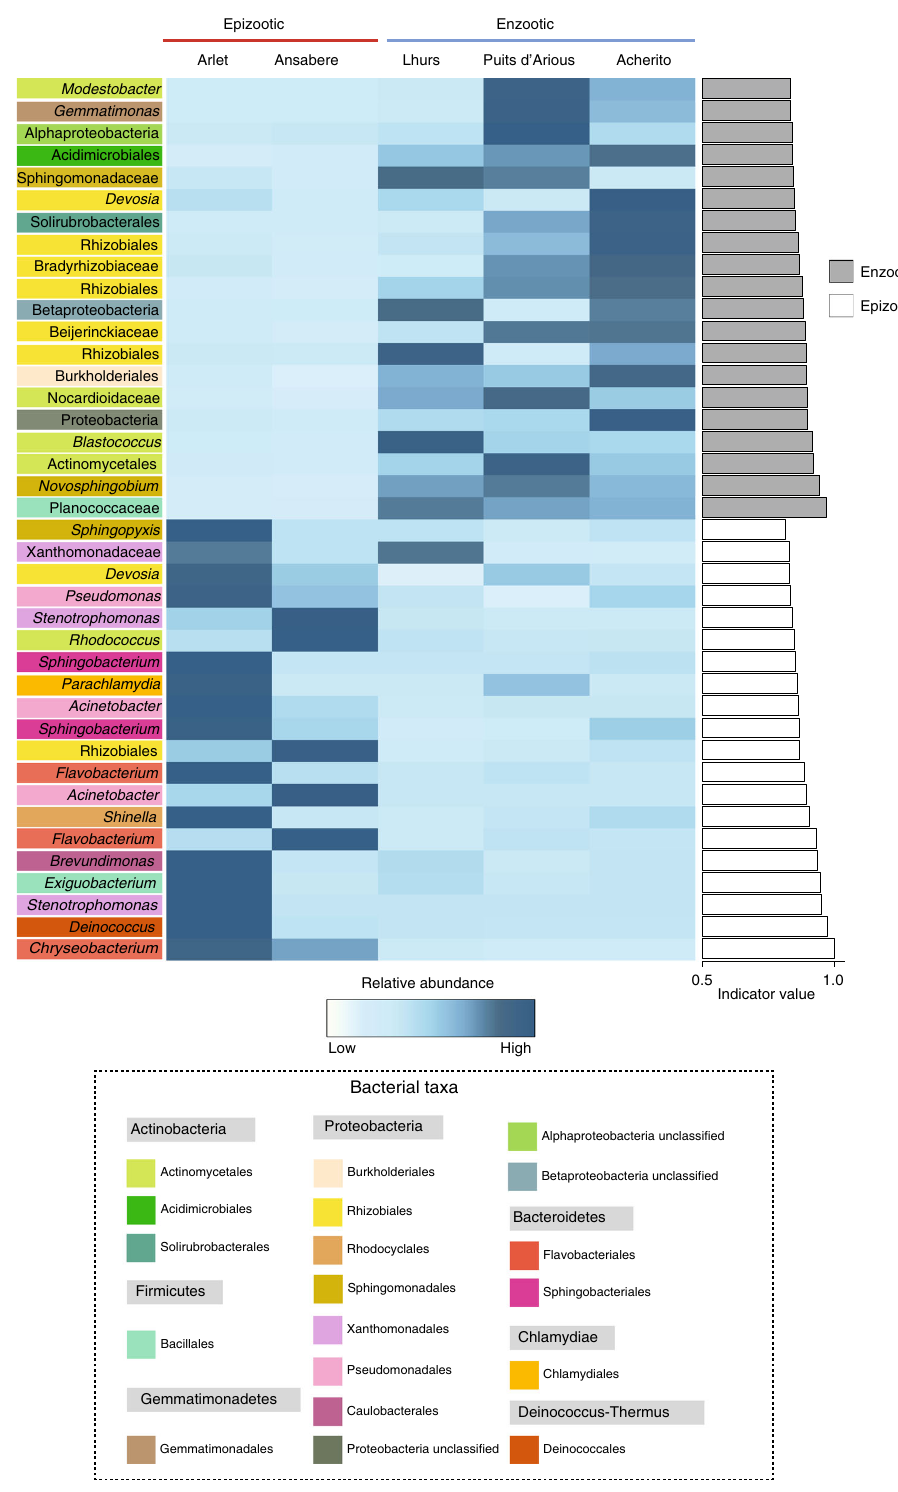
Fig. 4 Heatmap displaying the normalised relative abundance of the top 20 bacterial OTUs from enzootic and epizootic populations identi fi ed from indicator analysis. Sample sizes were: Enzootic = 32 (Acherito = 14, Lhurs = 11, Puits d ’ Arious = 7); Epizootic = 19 (Arlet = 16, Ansabere =